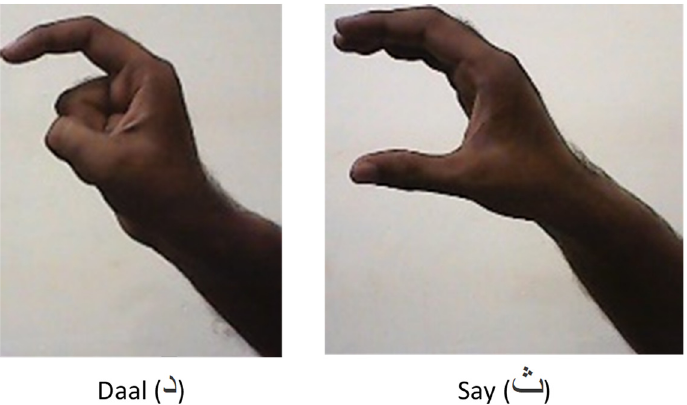
Figure 19. Processing similar gestures (PSL dataset) scenario 2.